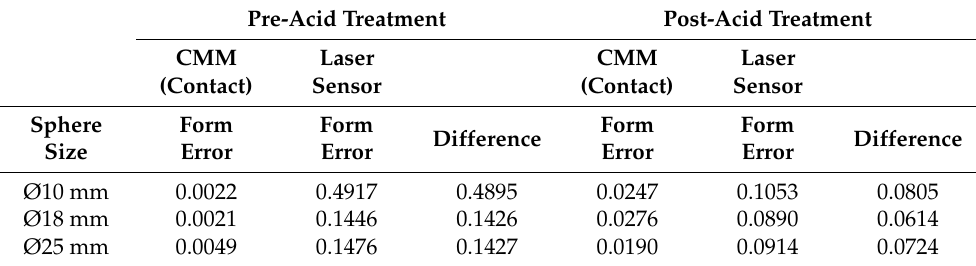
Table 2. Comparison of contact and noncontact measurements (mm) regarding form error pre- and post-acid